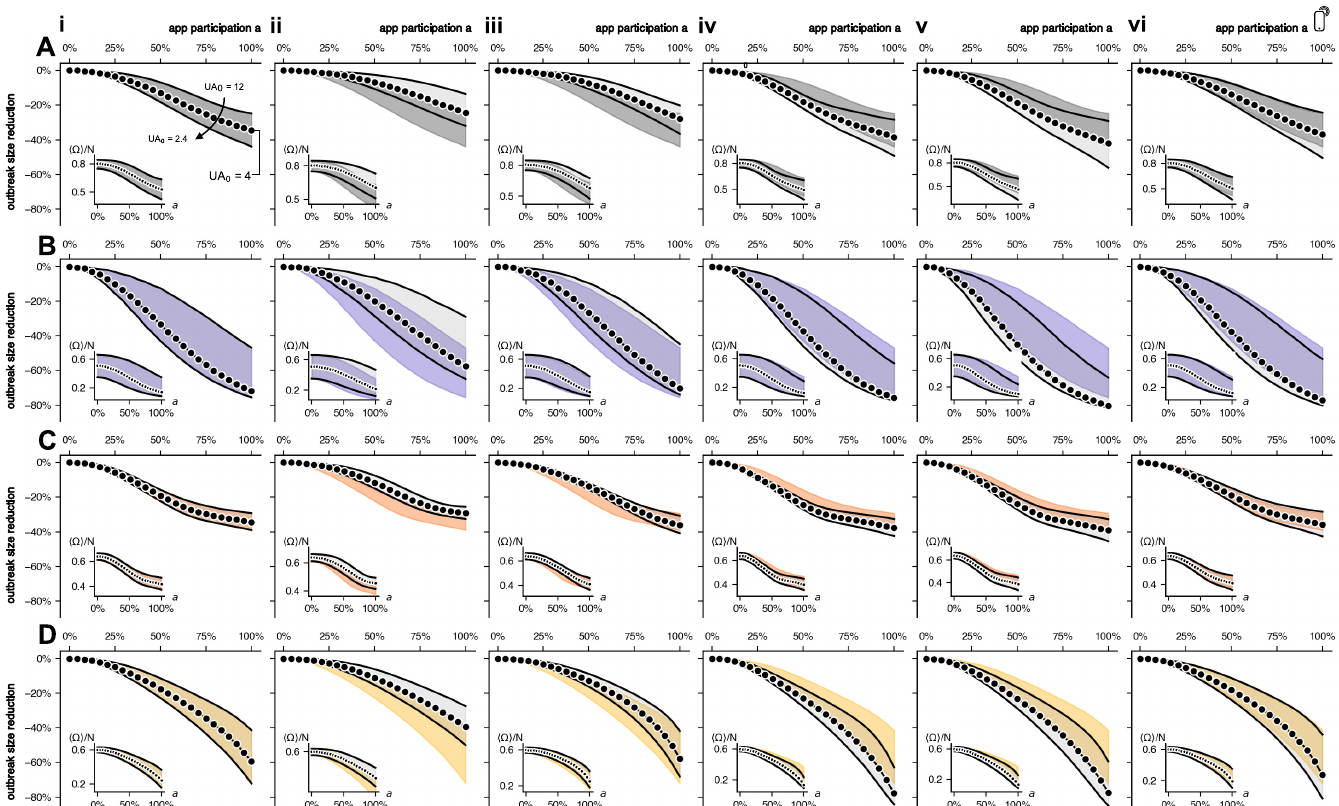
Fig 8. Outbreak size h O i / N and relative outbreak size reduction caused by DCT with UA 0 = 12 (upper boundary), UA 0 = 4 (dotted) and UA 0 = 2.4 (lower boundary) caused by q 2 {0.1, 0.3, 0.5}, respectively, for increasing app participation a . Simulated on (A) ER, (B) WS, (C) EXP, and (D) WS-EXP networks with (i) the base parameter assumptions (in all subfigures highlighted in color for easier comparison), (ii) with only 50% of traced contacts reacting to a notification (iii) without isolation of susceptible contacts, (iv) where 100% ( y = 1) of traced infected contacts can induce further tracing, (v) every app user uploads their result ( z = 1) and, (vi) the delay of the event T ( ! X ( is minimized ( χ = a ) a )